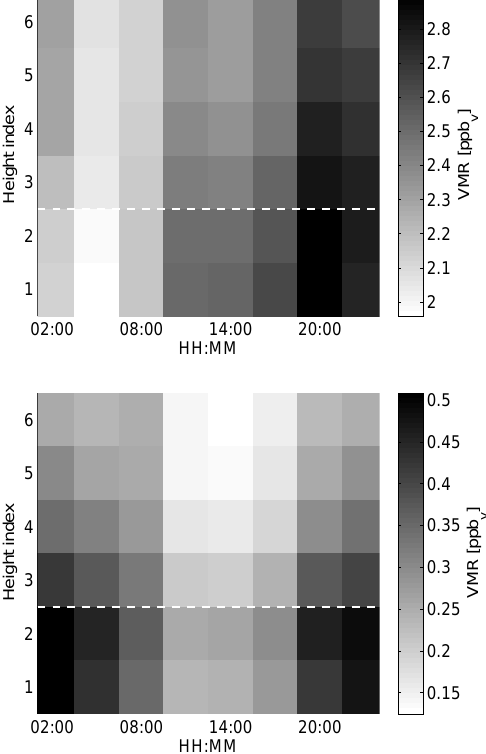
Figure 8. Mean diurnal VMR profiles of methanol (upper panel) and monoterpenes (lower panel, June–August, 2010–2013). Height indexes 1, 2, 3, 4, 5 and 6 correspond to the levels 4.2, 8.4, 16.8, 33.6, 50.4 and 67.2 m, respectively. The white dashed line shows the height of the canopy